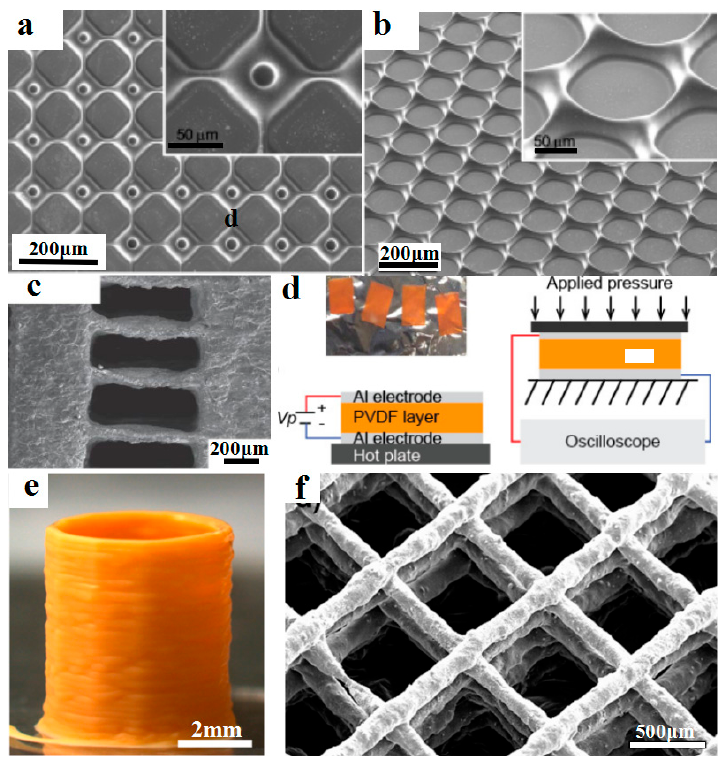
Figure 9. 4D-printed smart piezoelectric microstructures. ( a , b ) Different microstructures printed by digital projection printing (DPP), including ( a ) square arrays and ( b ) honeycomb arrays,